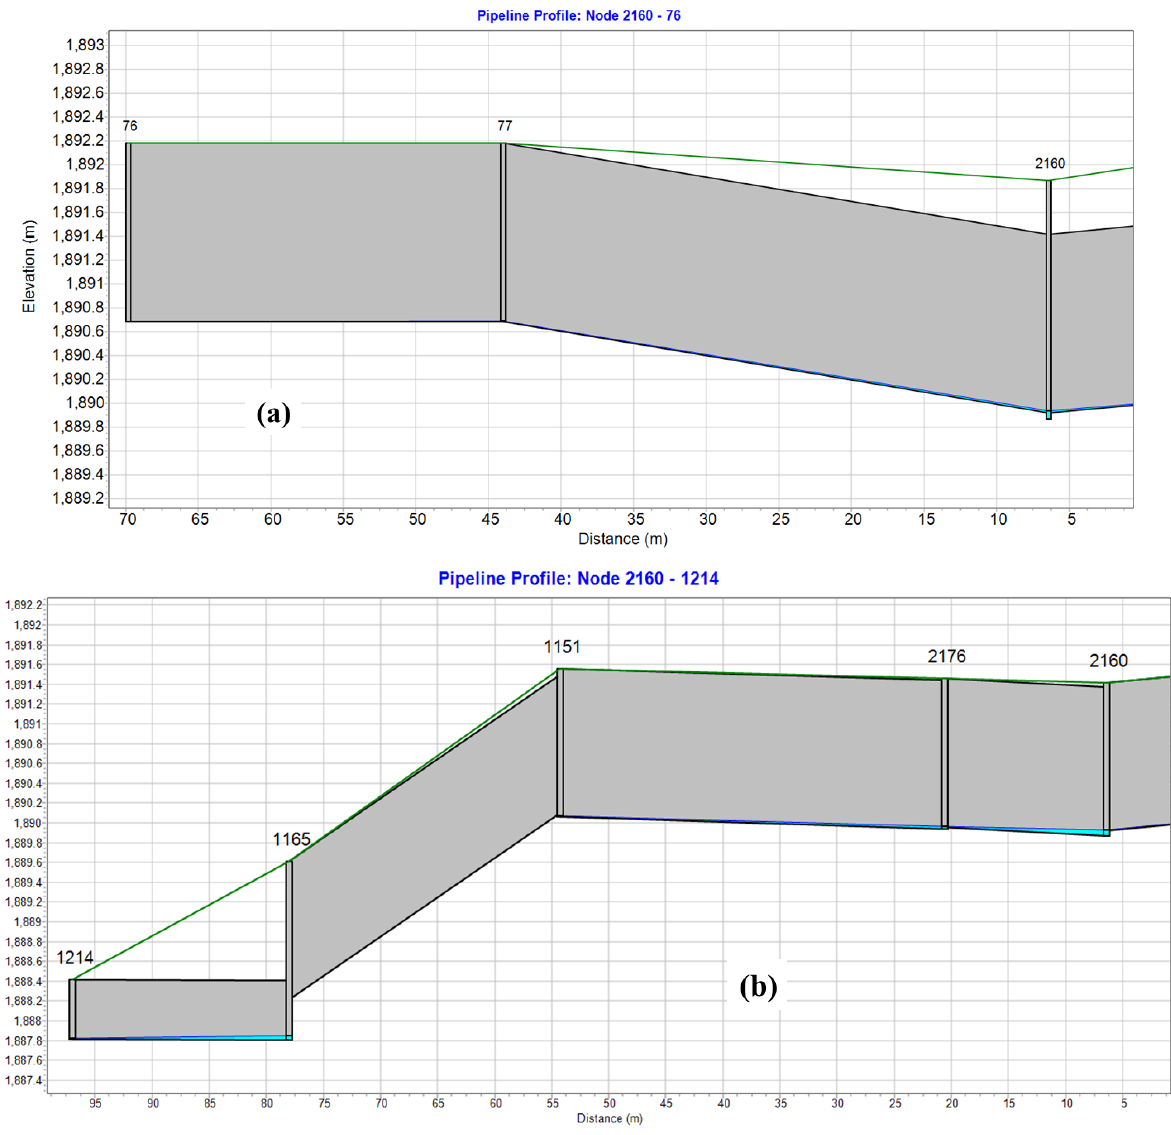
Figure 13. Branchpoint to outfall pipelines side profile. ( a ) branchpoint”2160” to outfall “76”; ( b ) branchpoint”2160” to outfall “1214” .